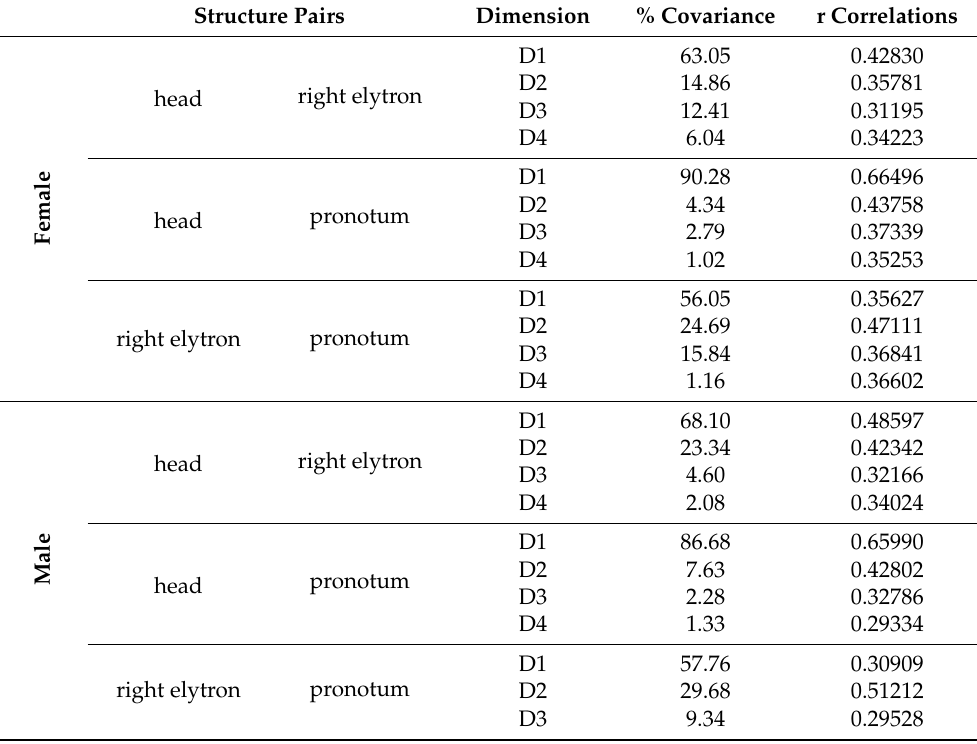
Table 3. Results of the PLS analysis for each pair of the examined structures. Only the dimensions showing in the permutation tests a number and percent of correlations 0.10 were included in the table. The first dimension was higher than this value, and the following ones were discarded. Additionally, the dimensions with percent of covariance < 1.0 were discarded. Only D1 is being discussed in the text, since the covariance values of the other dimensions were less than half of the first